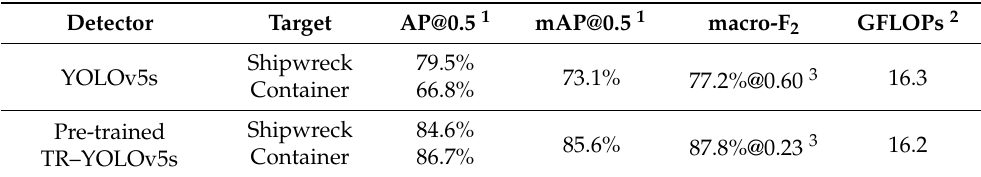
Table 3. The comparison of AP, macro-F 2 and GFLOPs between YOLOv5s and pre-trained TR–